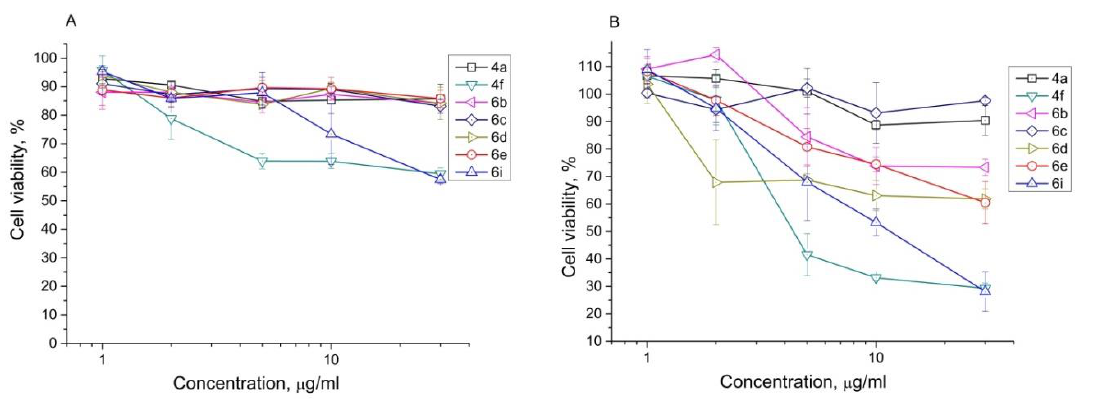
Figure 5. Cytotoxicity of Selected Racemic Spiro-Adducts 4 and 6 against the K562 cell line for 24 h ( A ) and 72 h ( B ).